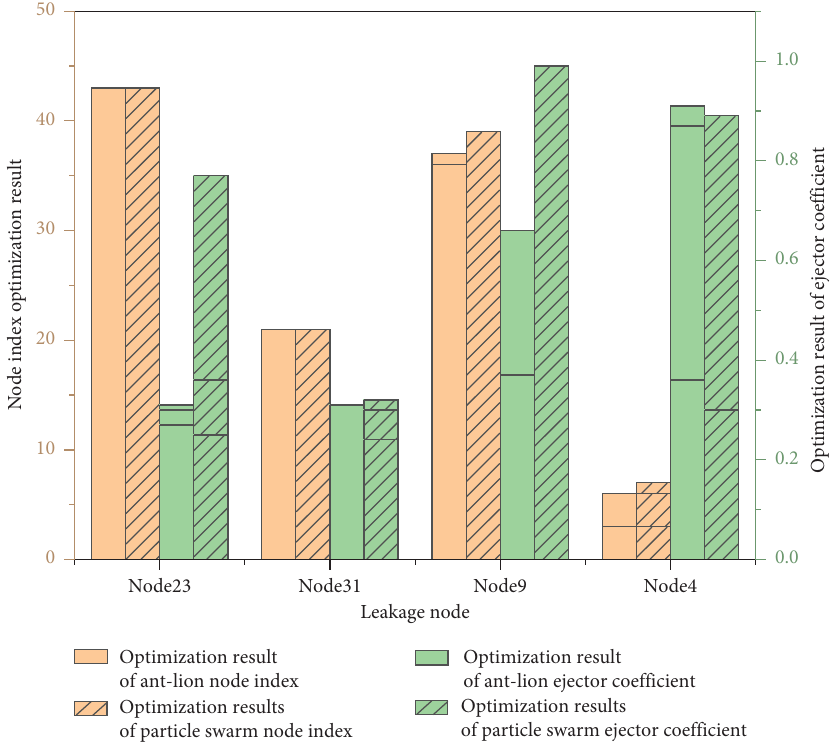
Figure 6: Leak location results of the ant lion algorithm and particle swarm optimization algorithm.